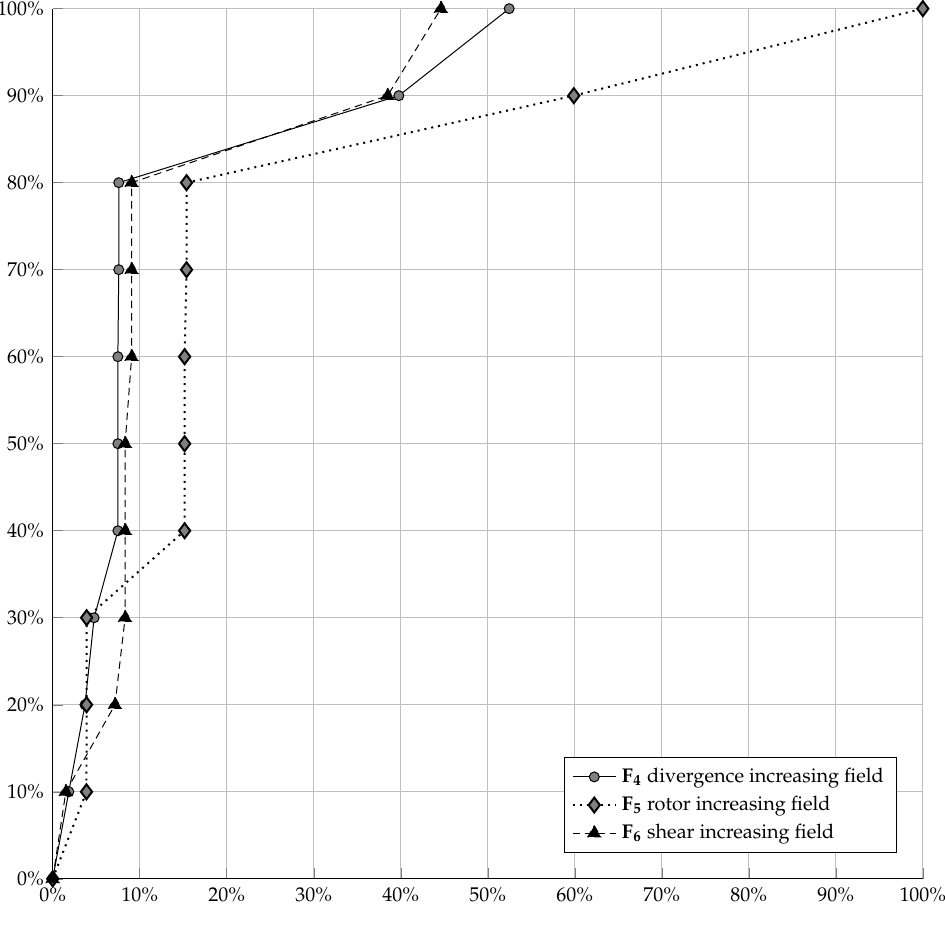
Figure 8. Plots of dependences U ( V ) in the forecast from the fields of F 4 divergence increasing fields, F 5 rotor, and F 6